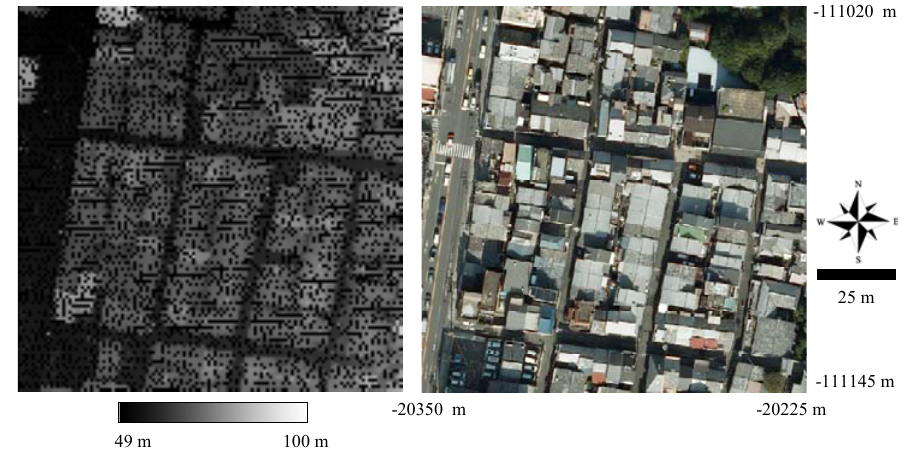
Figure 8. Airborne LiDAR data ( left ) and aerial image ( right ).